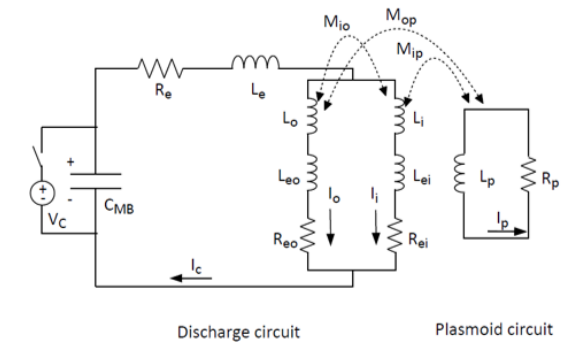
Figure 17. Equivalent circuit model of an AFRC (from [54]; reproduced with permission of the author). Challenges with Equivalent Circuit